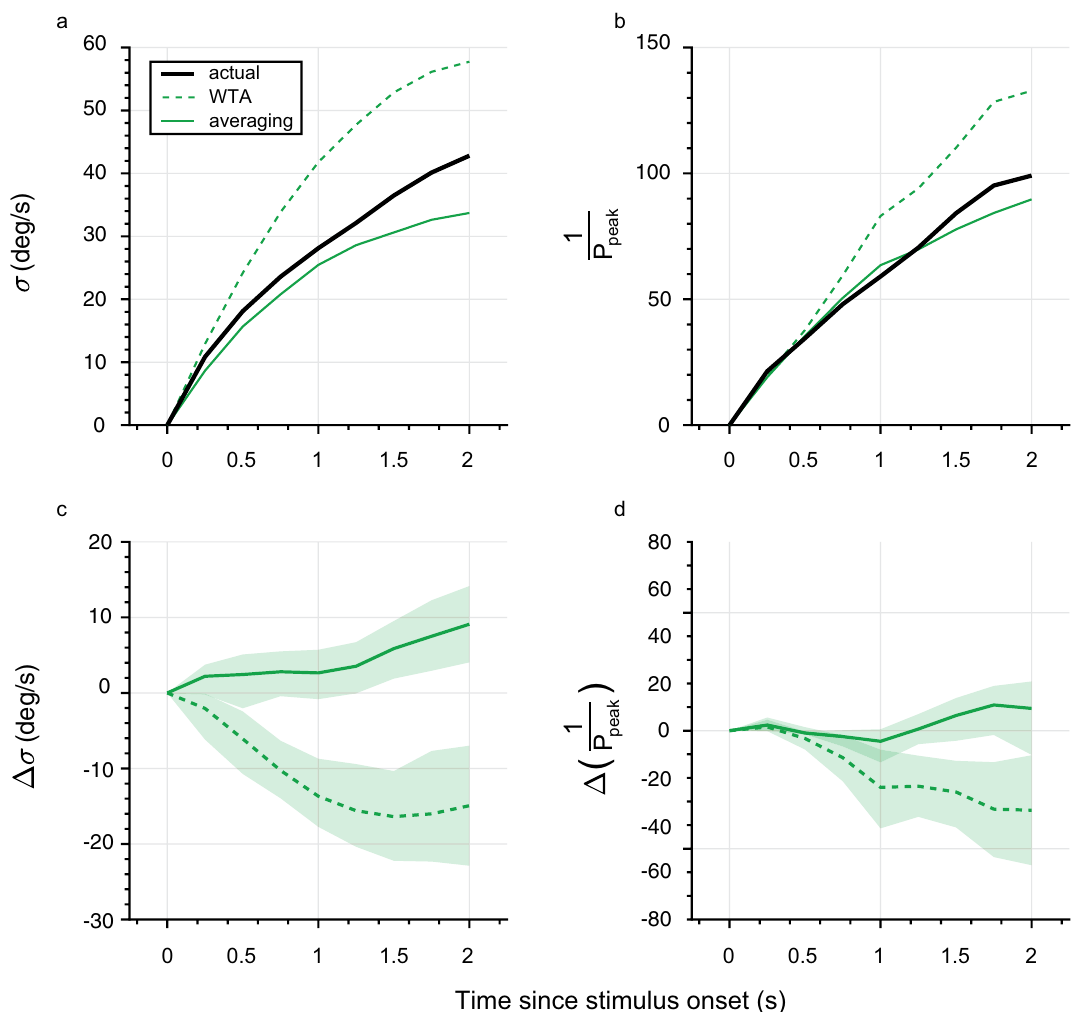
Figure 3. Temporal characteristics. ( a ) Averaged standard deviation of measured OLRs to bidirectional transparent motion (actual; solid black line) compared to that of WTA (dashed green line) and averaging (solid green line) predictions. ( b ) Inverse of the peak probability of measured OLR data (actual; solid black line) compared to that of WTA (dashed green line) and averaging (solid green line) predictions. ( c ) Difference in average standard deviation between measured OLR and WTA (dashed green line) or averaging (solid green line) predictions. ( d ) Difference in inverse peak probability between measured OLR and WTA (dashed green line) or averaging (solid green line) predictions. All curves are averages across all animals ( n = 5). Shaded areas represent 95% confidence intervals of the mean across animals ( n =